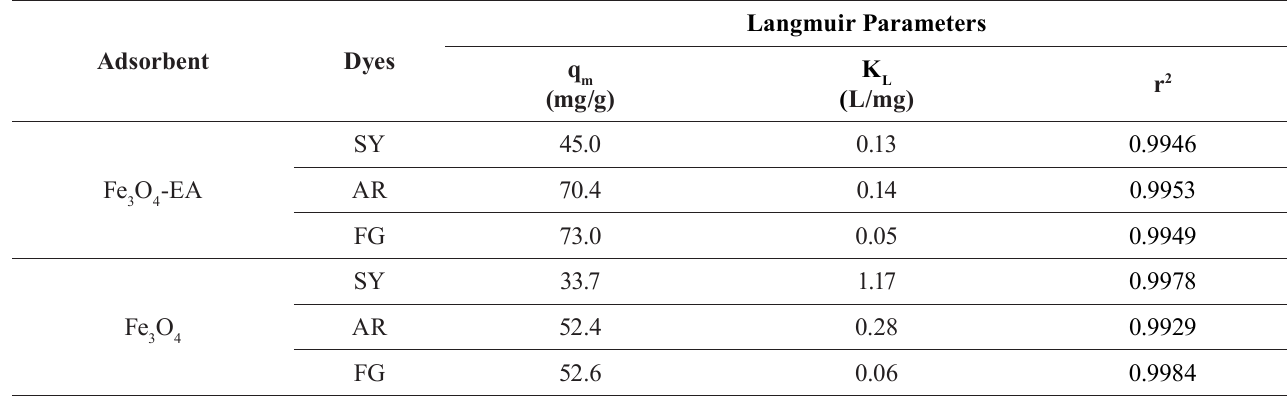
O -EA and Fe 3 4